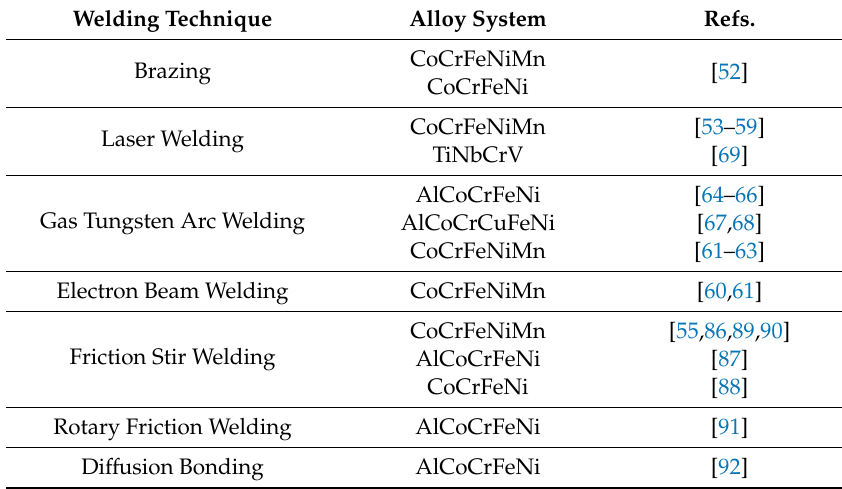
Figure 13. Percentage distribution of the number of papers considered in this study: ( a ) by welding technique; ( b ) by alloy system.